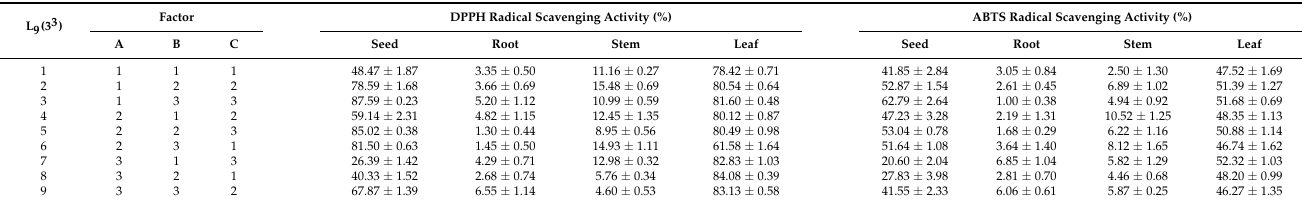
Table 2. The DPPH and ABTS radical scavenging ability of each part of Chenopodium formosanum . L9(33) Factor DPPHRadicalScavengingActivity(%)